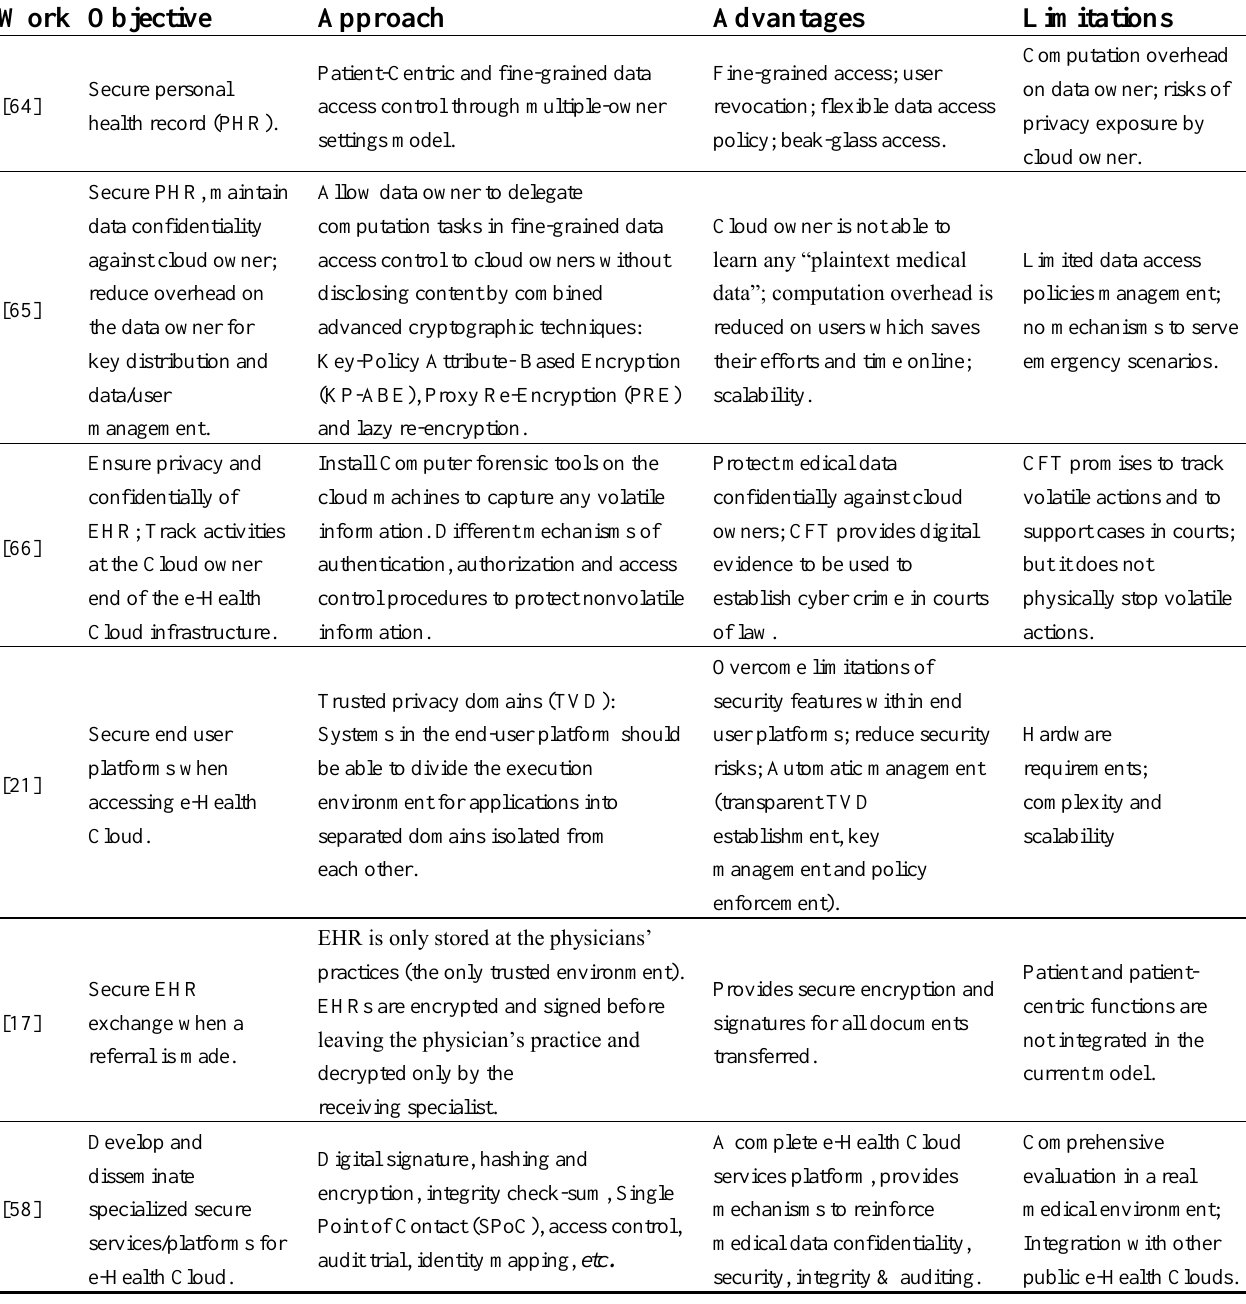
Table 1. Summary of various proposed security